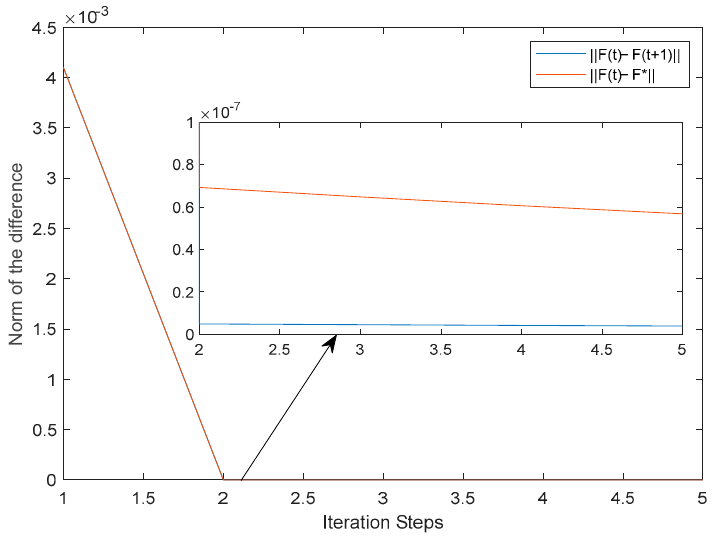
∗ (cid:107) during the iterative t − F t + 1 (cid:107) and (cid:107) F t − F